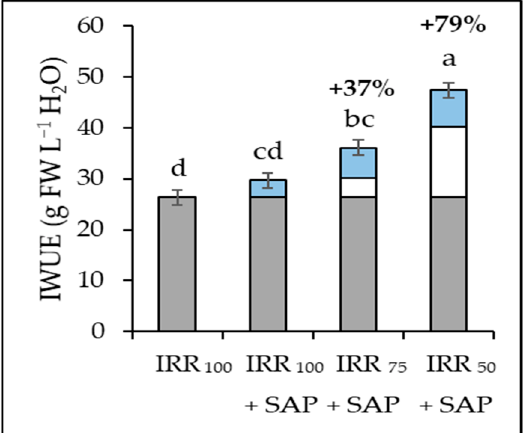
Figure 4. Effect on IWUE determined by the combination of irrigation treatment and SAP application to the soil. The white component of the columns represents the increase in the IWUE determined by the irrigation strategy (IWUE IRR), while the blue component is the increase in the IWUE determined by the application of SAP to the soil (IWUE SAP). Different letters indicate significant differences at p < 0.05. Vertical bars represent the standard error.